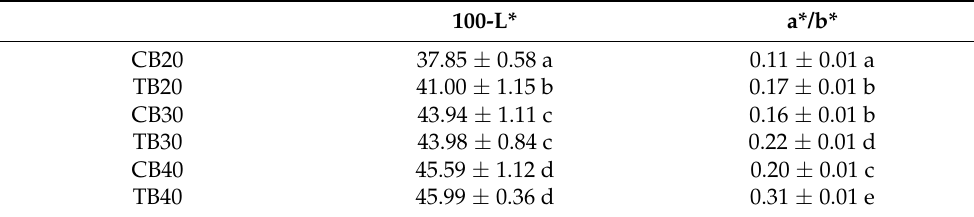
Table 1. Color attributes of polenta prepared from corn meal enriched in common (CB) and Tartary (TB) buckwheat flour at various ratios.